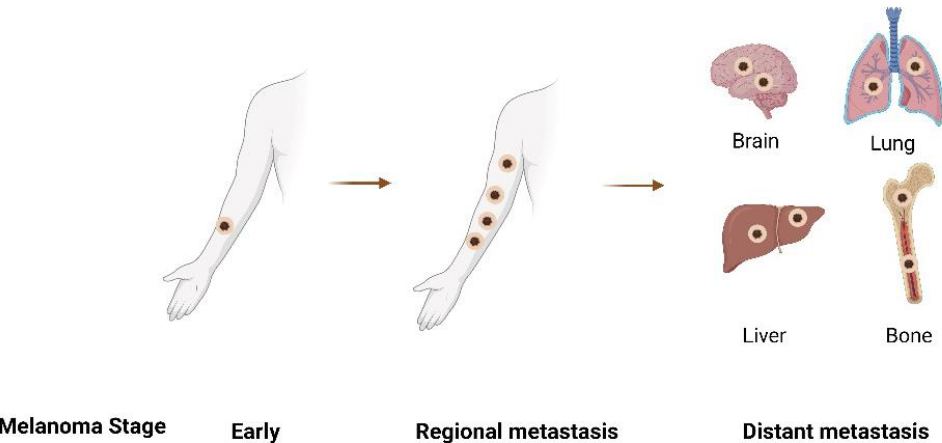
Figure 2. Different stages of melanoma progression.